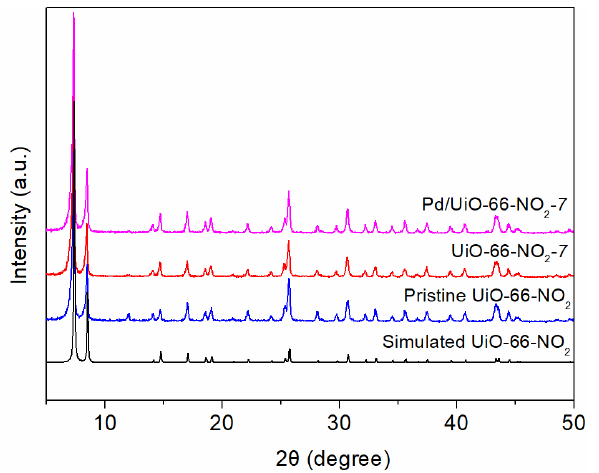
Figure 1. XRD patterns of the simulated UiO-66-NO 2 , pristine UiO-66-NO 2 , UiO-66-NO 2 - 7 , and Pd/UiO-66-NO 2 - 7 . Pd/UiO-66-NO 2 - 7